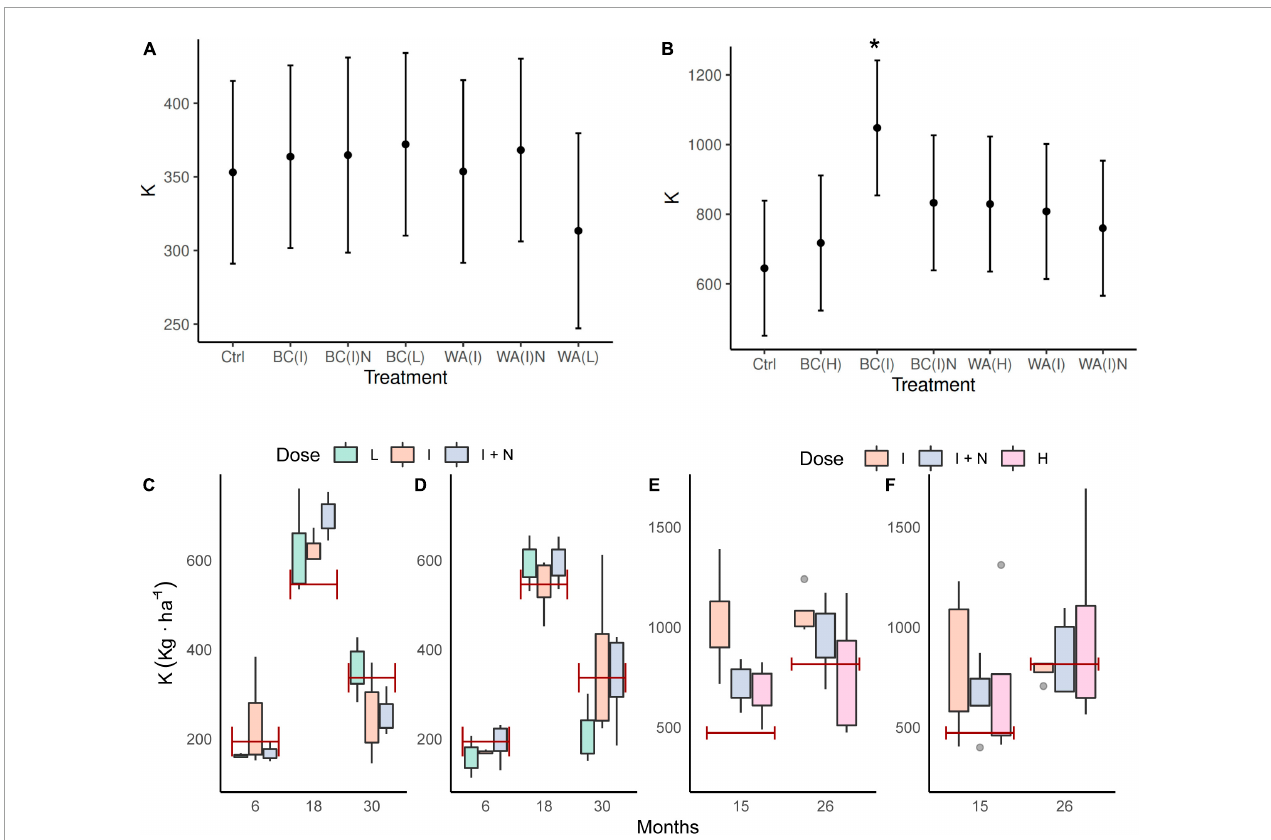
FIGURE2 Representation of Estimated Marginal Means (EMM) of K content (Kg ha − 1 ) in understorey biomass (top) by treatment and experimental site: Experimental site of Karrantza [ES-K, (A) ] and Experimental site of Oiz [ES-O, (B) ], and boxplots showing K content (Kg ha − 1 ) of understorey biomass at each experimental site: ES-K (C,D) and ES-O (E,F) during the time (X-axis). Values for biochar (BC) treatments are represented by boxplots (C,E) , and wood ash (WA) treatments are represented by boxplots (D,F) . EMM of control is represented in the boxplots by red lines, to provide a visual comparison. High dose (H, purple), intermediate dose (I, pink) and low dose (L, green); 0.8% of N (always with intermediate rate), (I + N, blue). Boxes show the density data within the first to the third quartile of the dataset for each treatment. The horizontal line inside the box represents the median value. The upper and lower whiskers extend from the higher to the lower K content data. Means which differ significantly from control are in bold and mark with asterisks (* p <